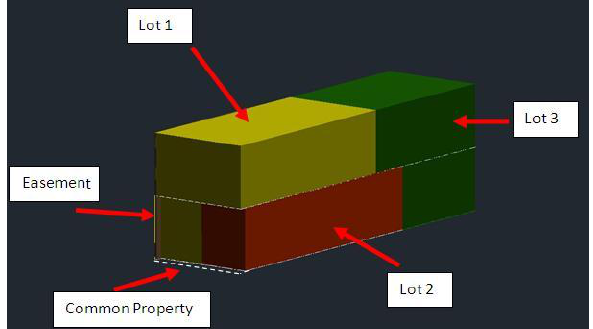
Figure 15. A building with three Lots, a common property,